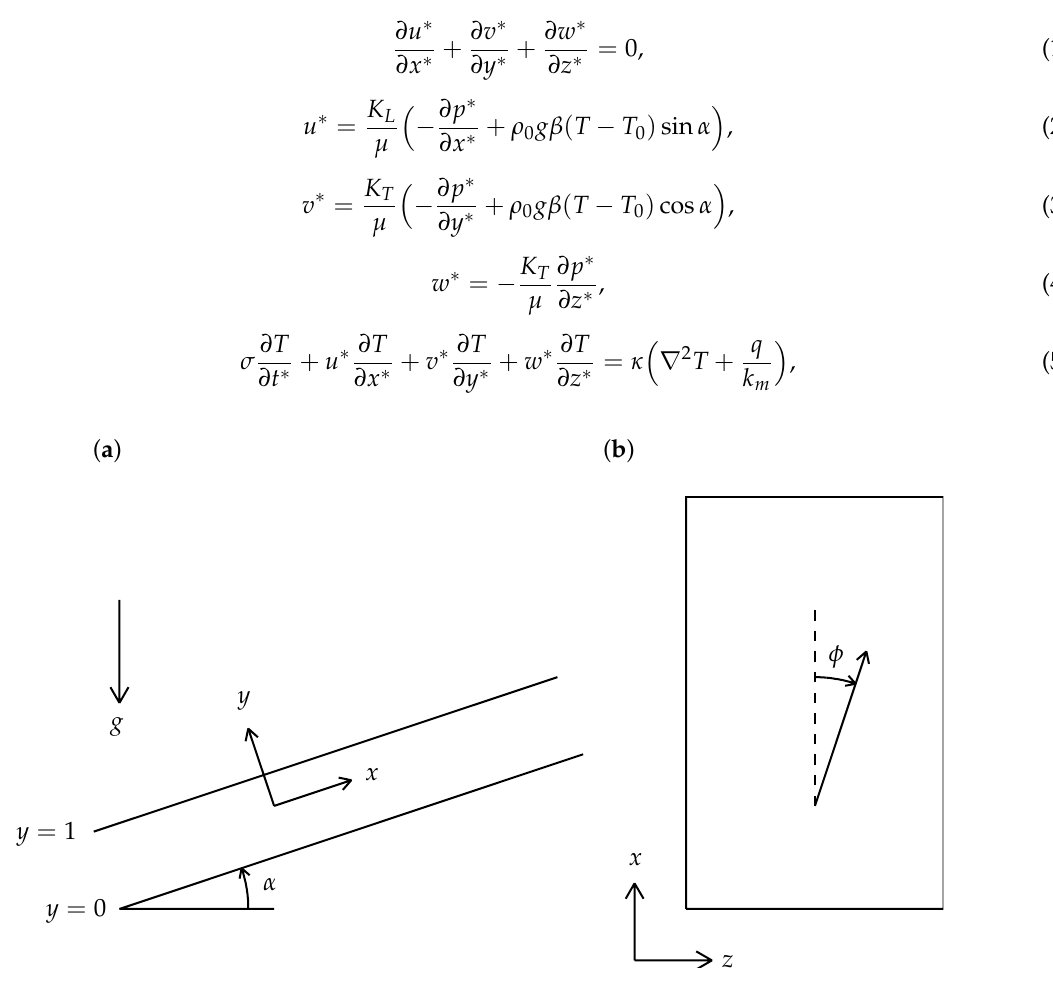
Figure 1. Definition sketch of the inclined layer showing the coordinate directions, the inclination angle, α , and the direction of the rolls, φ , relative to the x -direction. ( a ) side view; ( b ) plan